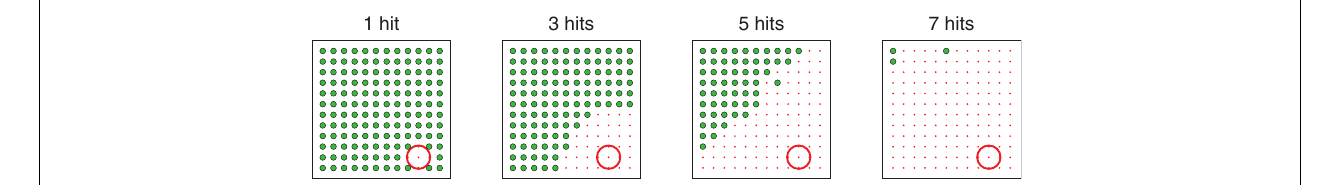
FIGURE 4 | Illustration of the “bias zone” effect. In each graph, the target was first hit N times (labeled at the top of the graph). Then, learning was turned off and movement for each possible value of G exp was evaluated. Each dot represents the spatial location corresponding to G exp . Large green dots